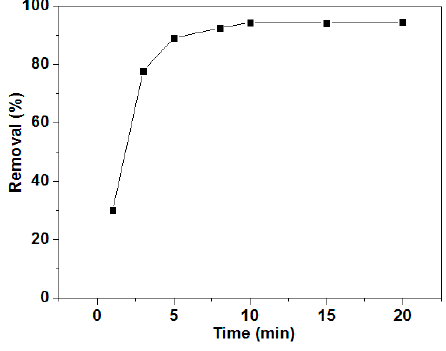
Figure 10. Iron desorption kinetics by oxalic acid.